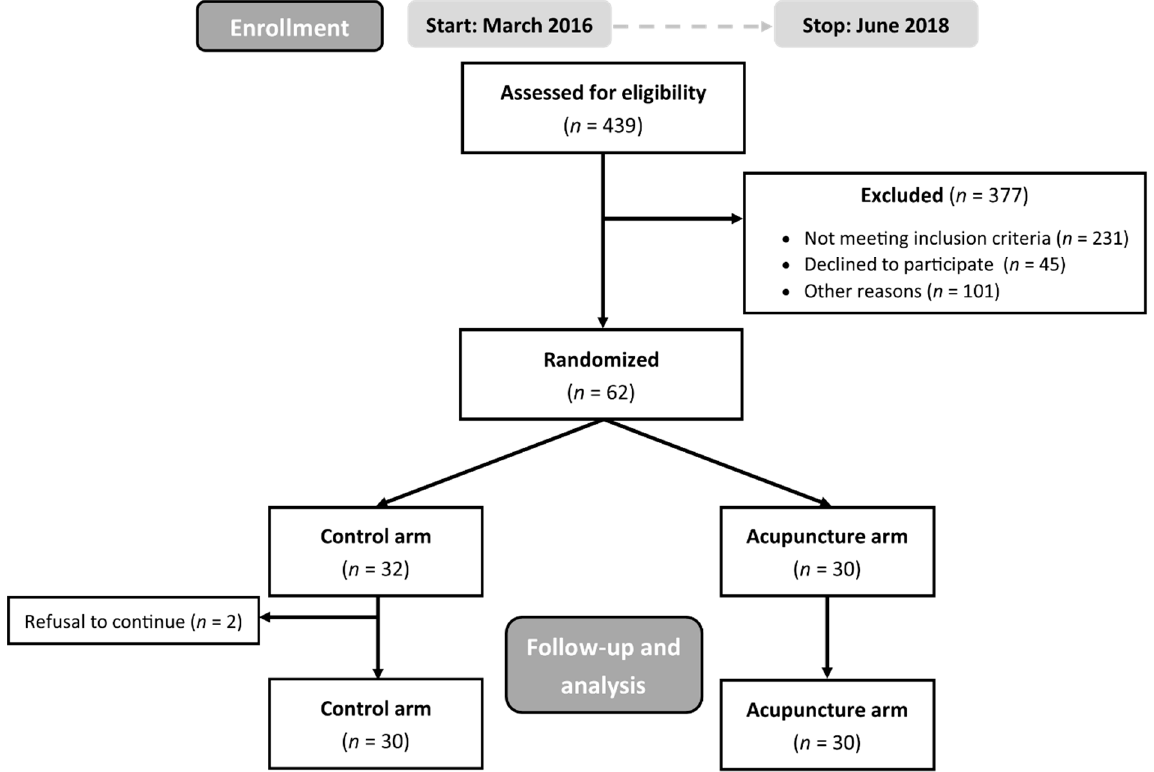
Figure 1. CONSORT flow diagram of the study participants.